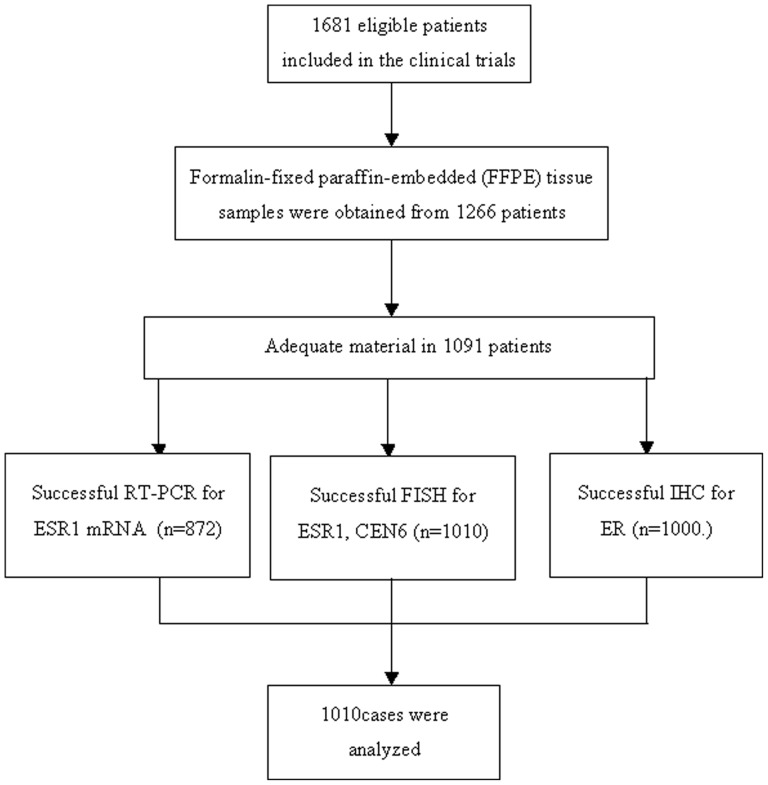
REMARK flow chart.